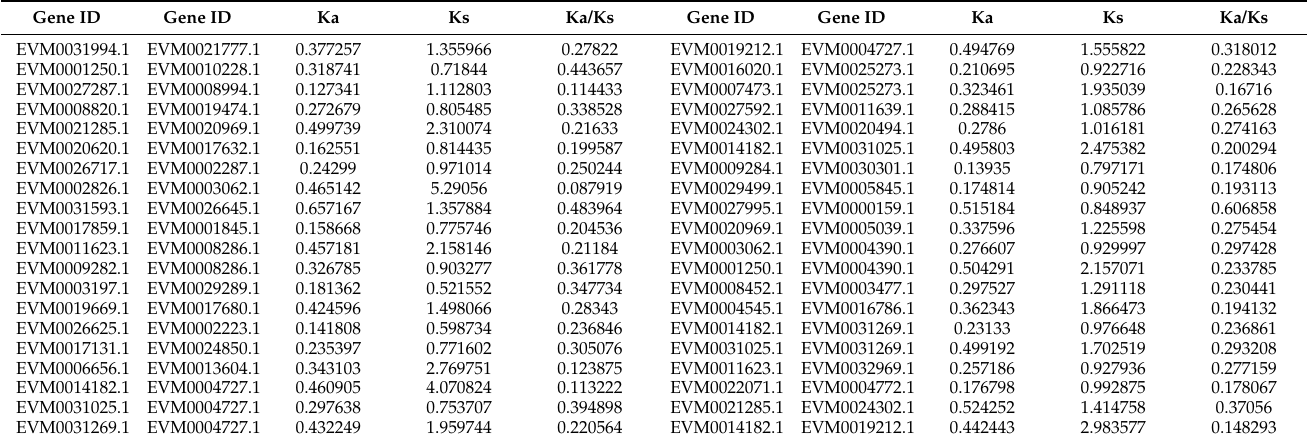
Table 1. Ka, Ks, and Ka/Ks statistics of